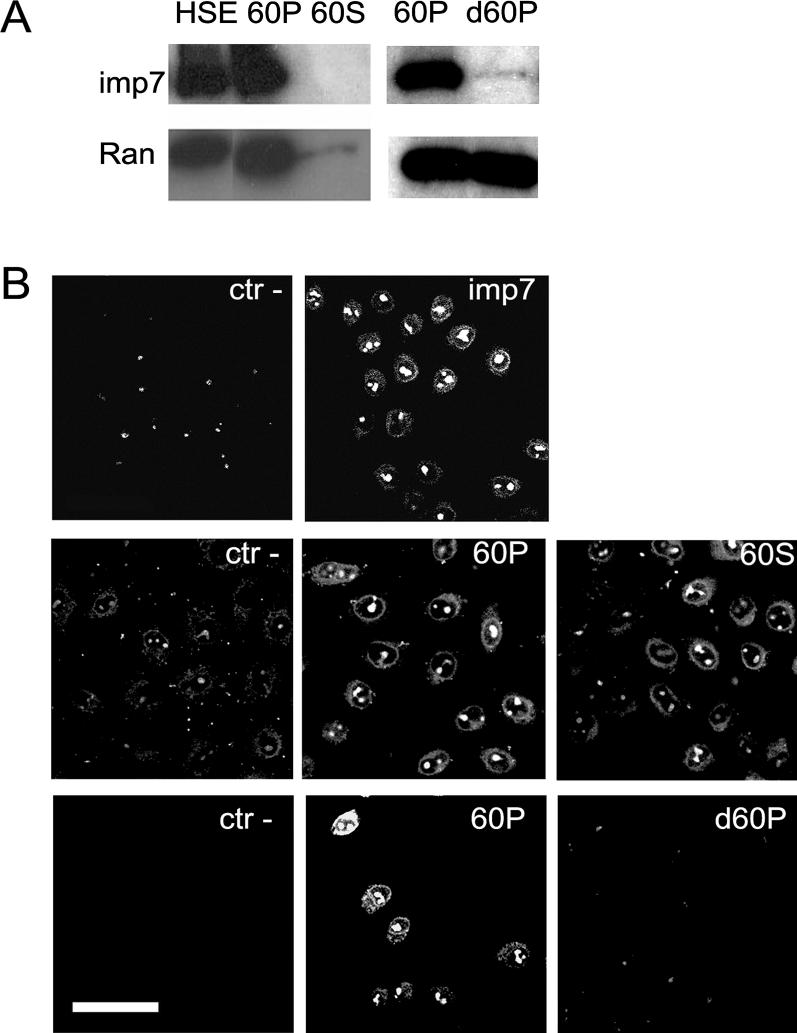
imp7 and Additional Cytosolic Factors Support RTC Nuclear Import(A) Western blot showing depletion of both imp7 and Ran in the supernatant (60S) of the 60% AS precipitation step and depletion of imp7 but not Ran from the 60% AS precipitation pellet (60P) after low-substitution Phenyl-Sepharose chromatography (d60P).(B) Nuclear import in permeabilized HeLa cells in the presence of labelled RTCs, 1× energy-regenerating system and buffer (panel ctr−), 1μM imp7 + 1× Ran mix (panel imp7), 0.5 mg/ml of the pellet (panel 60P) or supernatant (panel 60S) fractions from the 60% AS precipitation step, or 60P after low-substitution Phenyl-Sepharose chromatography (panel d60P). Images were acquired by confocal microscopy using the same settings. Scale bar indicates 25 μm.